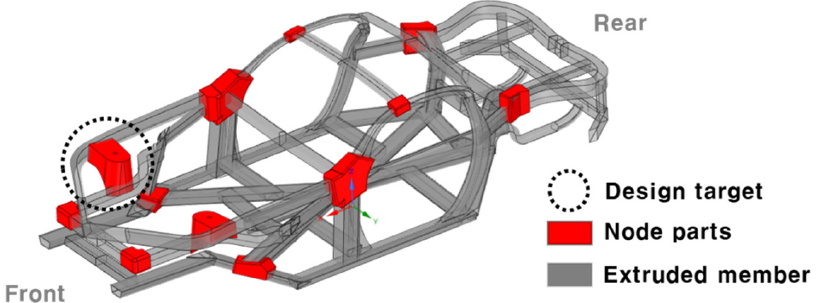
Figure 4. Space frame and node parts of the vehicle.